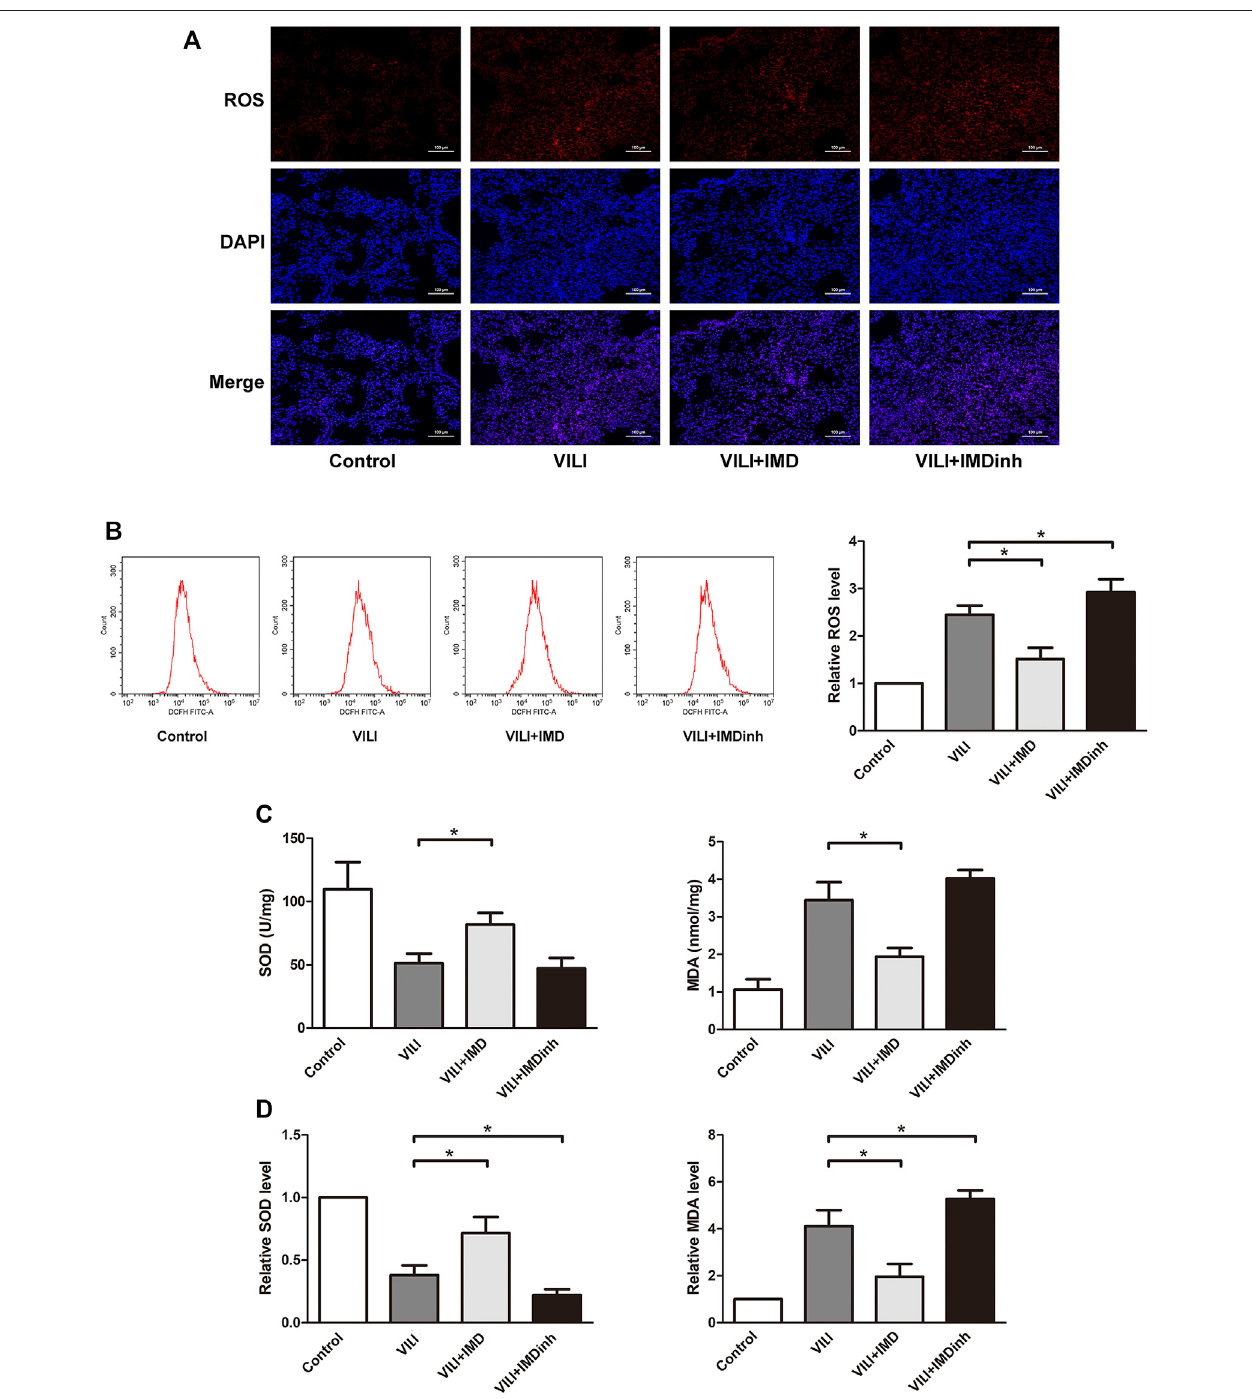
FIGURE 3 | IMD alleviated oxidative stress in mice and in ECs. (A) ROS staining of mice lung tissues. (B) Cell ROS was detected using fl ow cytometry. (C) The expression of SOD and MDA in mice lung tissues was measured by ELISA. (D) The expression of SOD and MDA in ECs was measured by ELISA. * p < 0.05.